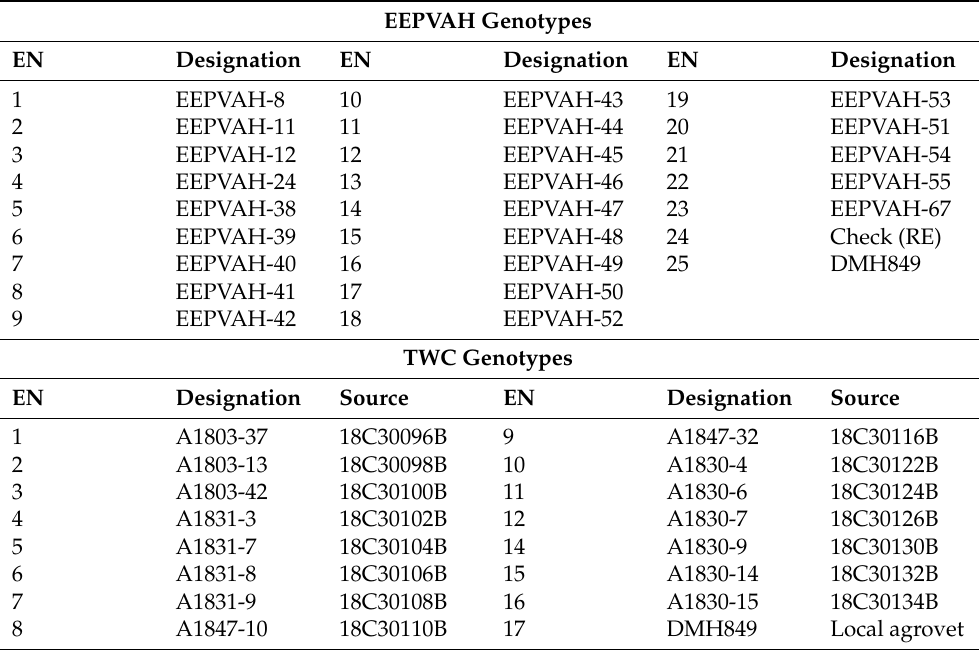
Table 1. Details of the genetic materials used in extra early multi-stress tolerant provitamin A and three-way cross zinc biofortified hybrid maize